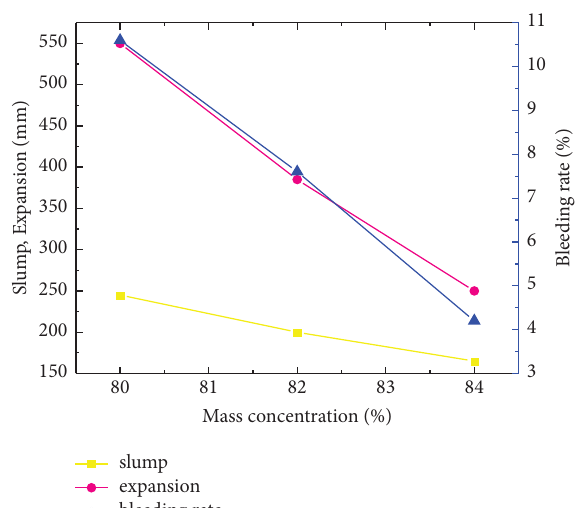
Figure 5: Test process.